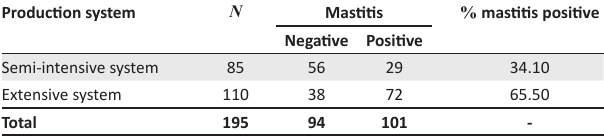
TABLE 2: Association between mastitis prevalence and mastitis risk factors.